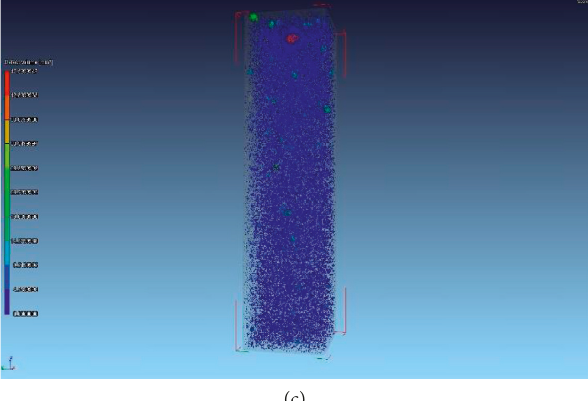
Figure 11: CT scan of steel slag cementitious materials. (a) Natural curing without microorganism. (b) Carbonation without microor- ganism. (c) Microorganism mineralization.